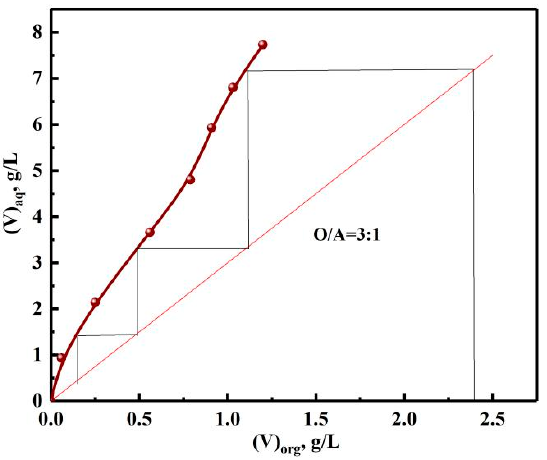
Figure 18. Stripping McCabe–Thiele graph of vanadium. Table 4. Chemical composition of four-stage countercurrent stripping solution.